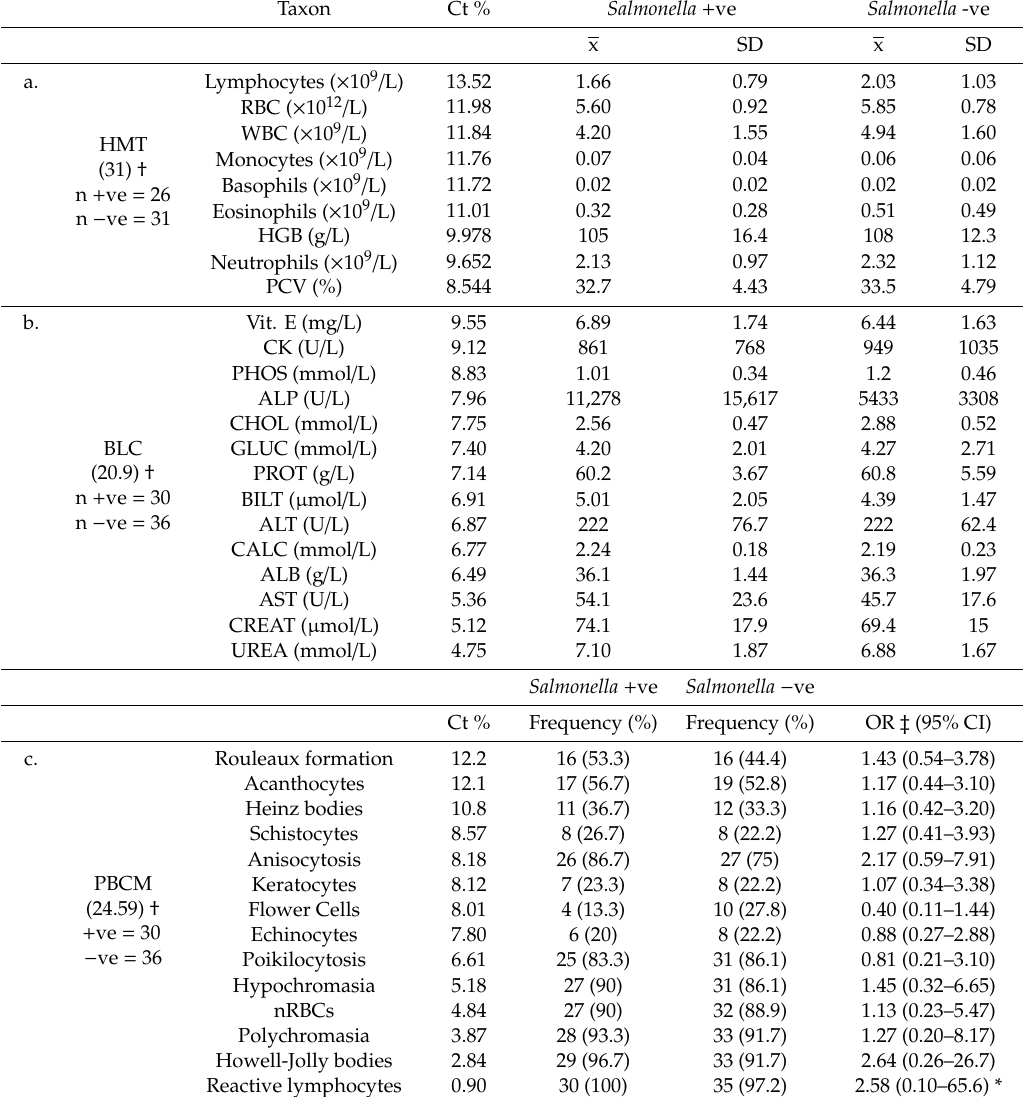
Table 2. SIMPER analysis results indicating the contribution of specific variables to the observed di ff erences in HMT (a), BLC (b), and PBCM (c) profiles of quokkas that were Salmonella -positive